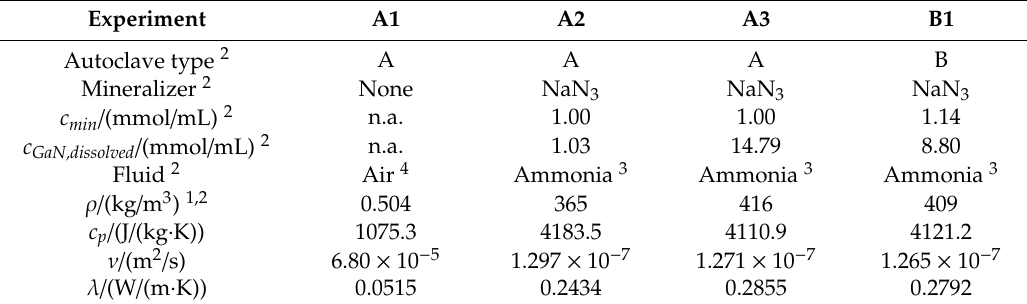
Table 2. Experimental parameters of experiments. Two thermocouples were placed in the fluid as shown in Figure 1. All experiments except for A3 were conducted without any ba ffl e. In experiment A3, a ba ffl e was used. In experiment A1, the autoclave was not hermetically sealed, thus the medium was air at atmospheric pressure. The concentration of the mineralizer is denoted as c min , whereas c GaN,dissolved refers to the dissolved amount of GaN based on gravimetric